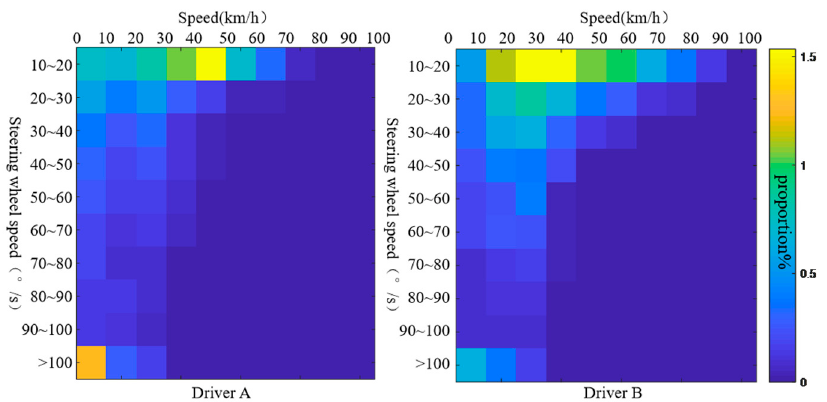
Figure 2. Joint distribution characteristics of vehicle speed and steering wheel speed.